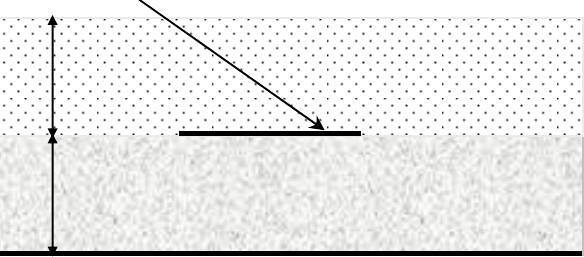
Figure 1: Geometrical Structure of a high T